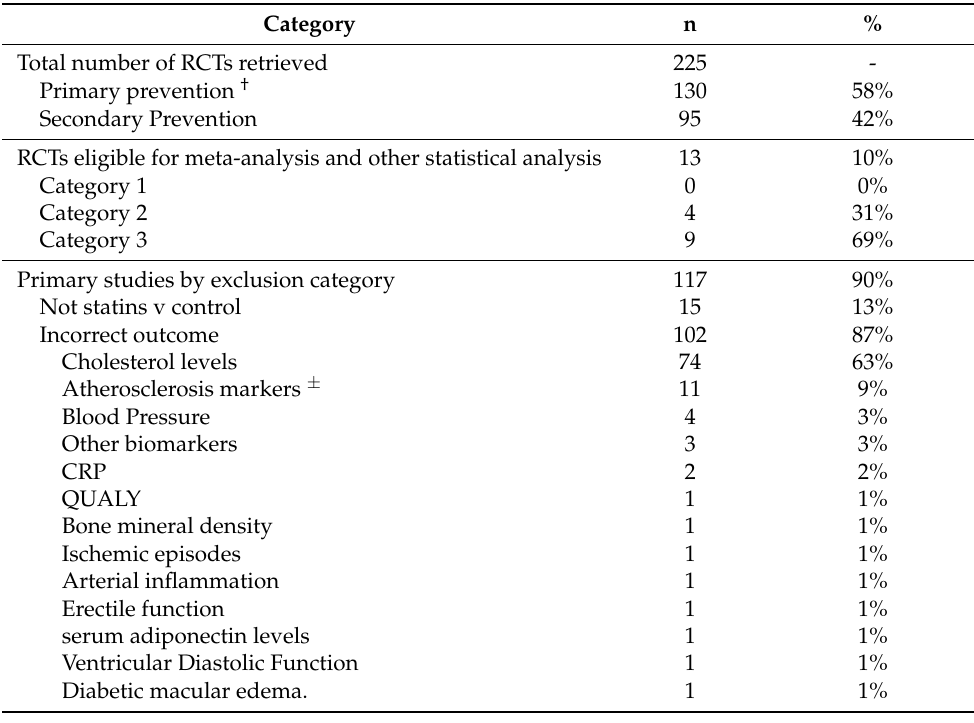
Table 3. Summary of studies retrieved split by primary prevention, secondary prevention and categorised by exclusion category and population. Category 1—100% without underlying health conditions or reported in sub-groups; Category 2—A percentage of participants included without underlying health conditions; Category 3—Underlying health conditions in 100% of participants.